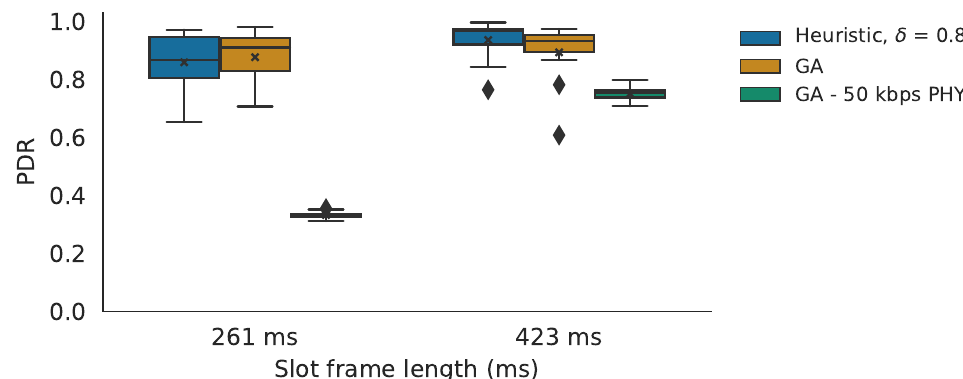
Figure 13. The PDRs values for the testbed experiments, showing the results for the heuristic, the GA and the GA that can only use the 50kbps PHY. The x denotes the mean value. The diamond shapes represent outliers that are values smaller than the minimum (i.e., the lower whisker), or larger than the maximum, value (i.e., the top